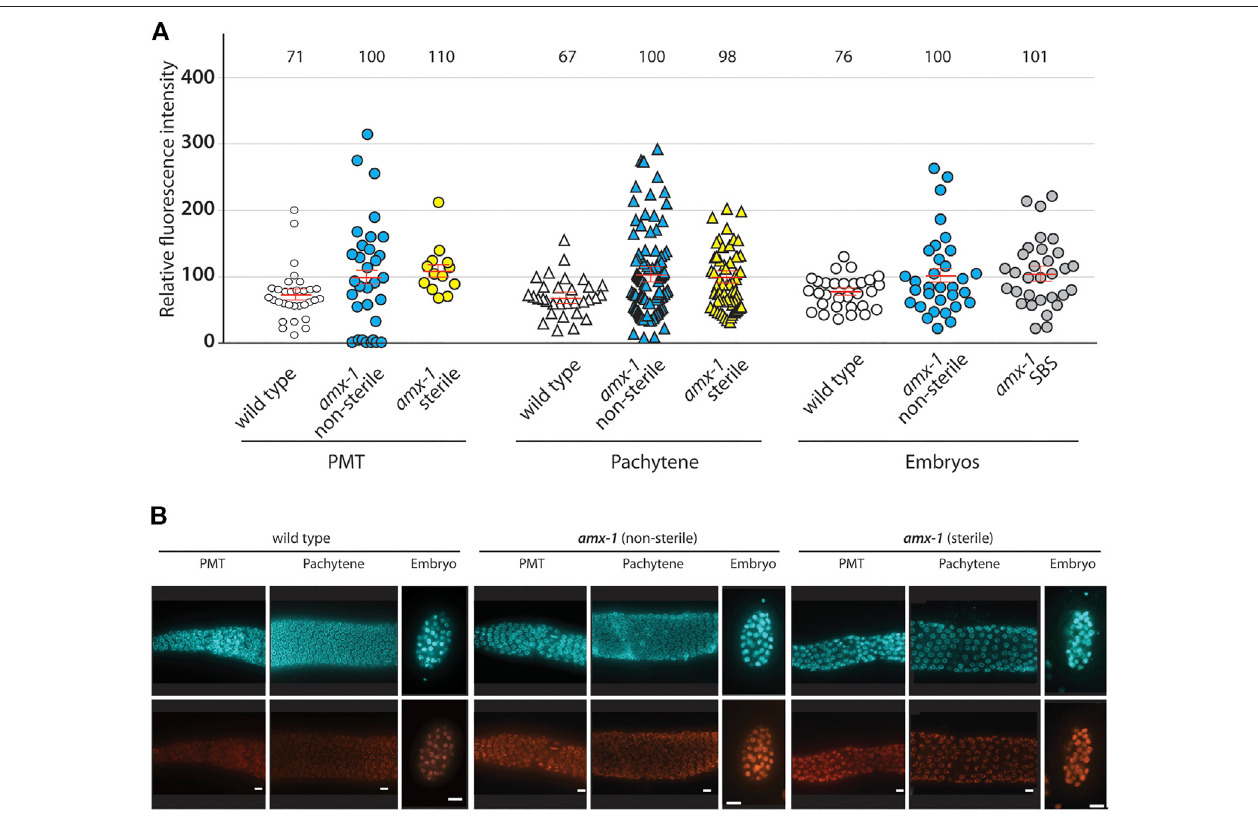
FIGURE7| SterilewormsdonotalterthelevelofH3K4me2inbothmitoticandmeioticgermline. (A) While amx-1 mutantsalteredH3K4me2levelcomparedtowild type (inPMT, p =0.0072;inpachytene, p =0.0032;inembryo, p =0.0075),nosigni fi cantchangewasdetectedinnucleibetweennon-sterile andsterileworms(inPMT, p = 0.5732; in pachytene, p = 0.9931; in embryo, p = 0.8456). Individual nuclei were sampled for fl uorescence intensity using ImageJ. The bars represent the mean fl uorescence intensity. N = 5 – 6 worms. (B) Representative images used for the analysis in (A) . Bars, 10